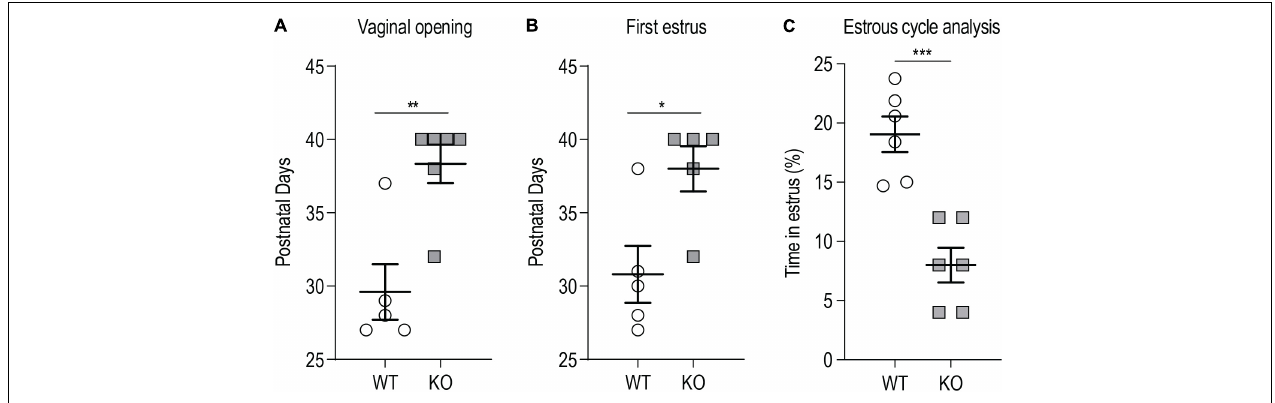
FIGURE 3 | p140Cap KO female mice show delayed puberty and abnormal estrous cyclicity. (A) Postnatal day at which the vaginal opening appears. n = 5 WT mice; 6 p140Cap KO mice. Mann-Whitney test, P = 0.009. (B) Postnatal day at which the first estrus (defined by the presence of a majority of cornified epithelial cells in vaginal smears) occurred. n = 5 WT mice; 5 p140Cap KO mice. Mann-Whitney test, P = 0.02. (C) Percentage of time spent in estrus phase during 20 days of observation. n = 6 WT mice; 6 p140Cap KO mice. Unpaired, two-tailed t -test, P < 0.001. Data are represented as means ± SEM. * = P < 0.05, ** = P < 0.01, *** = P < 0.001, ns = not